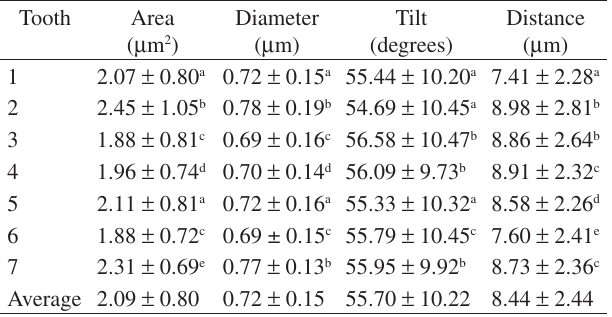
Table 2. Idem for the region parameters.